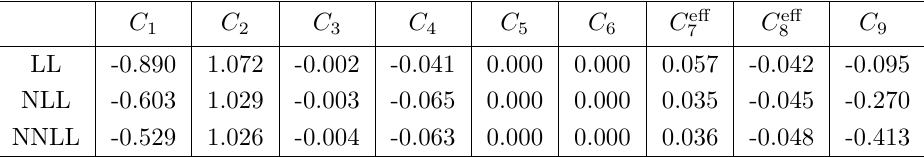
Table 4 . Value of the Wilson coefficients at the NNLL approximation given at scale µ c = 1 . 67 GeV , for µ = 4 . 18 GeV and µ = 80 . 4 GeV b W